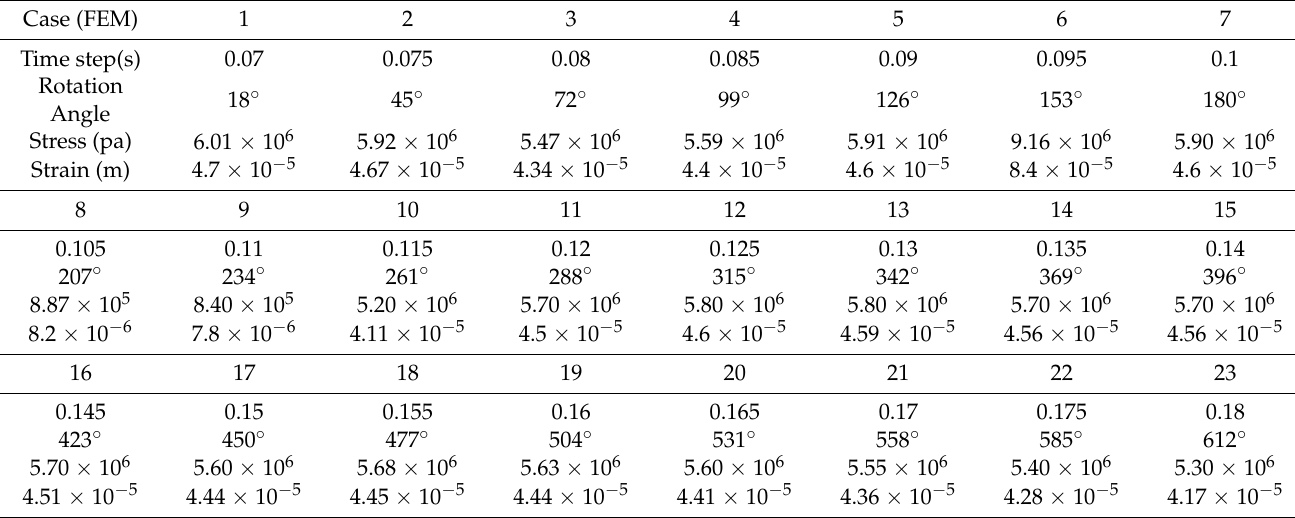
Table 9. The datasheet for the coupling procedure of v = 5 m/s test case.